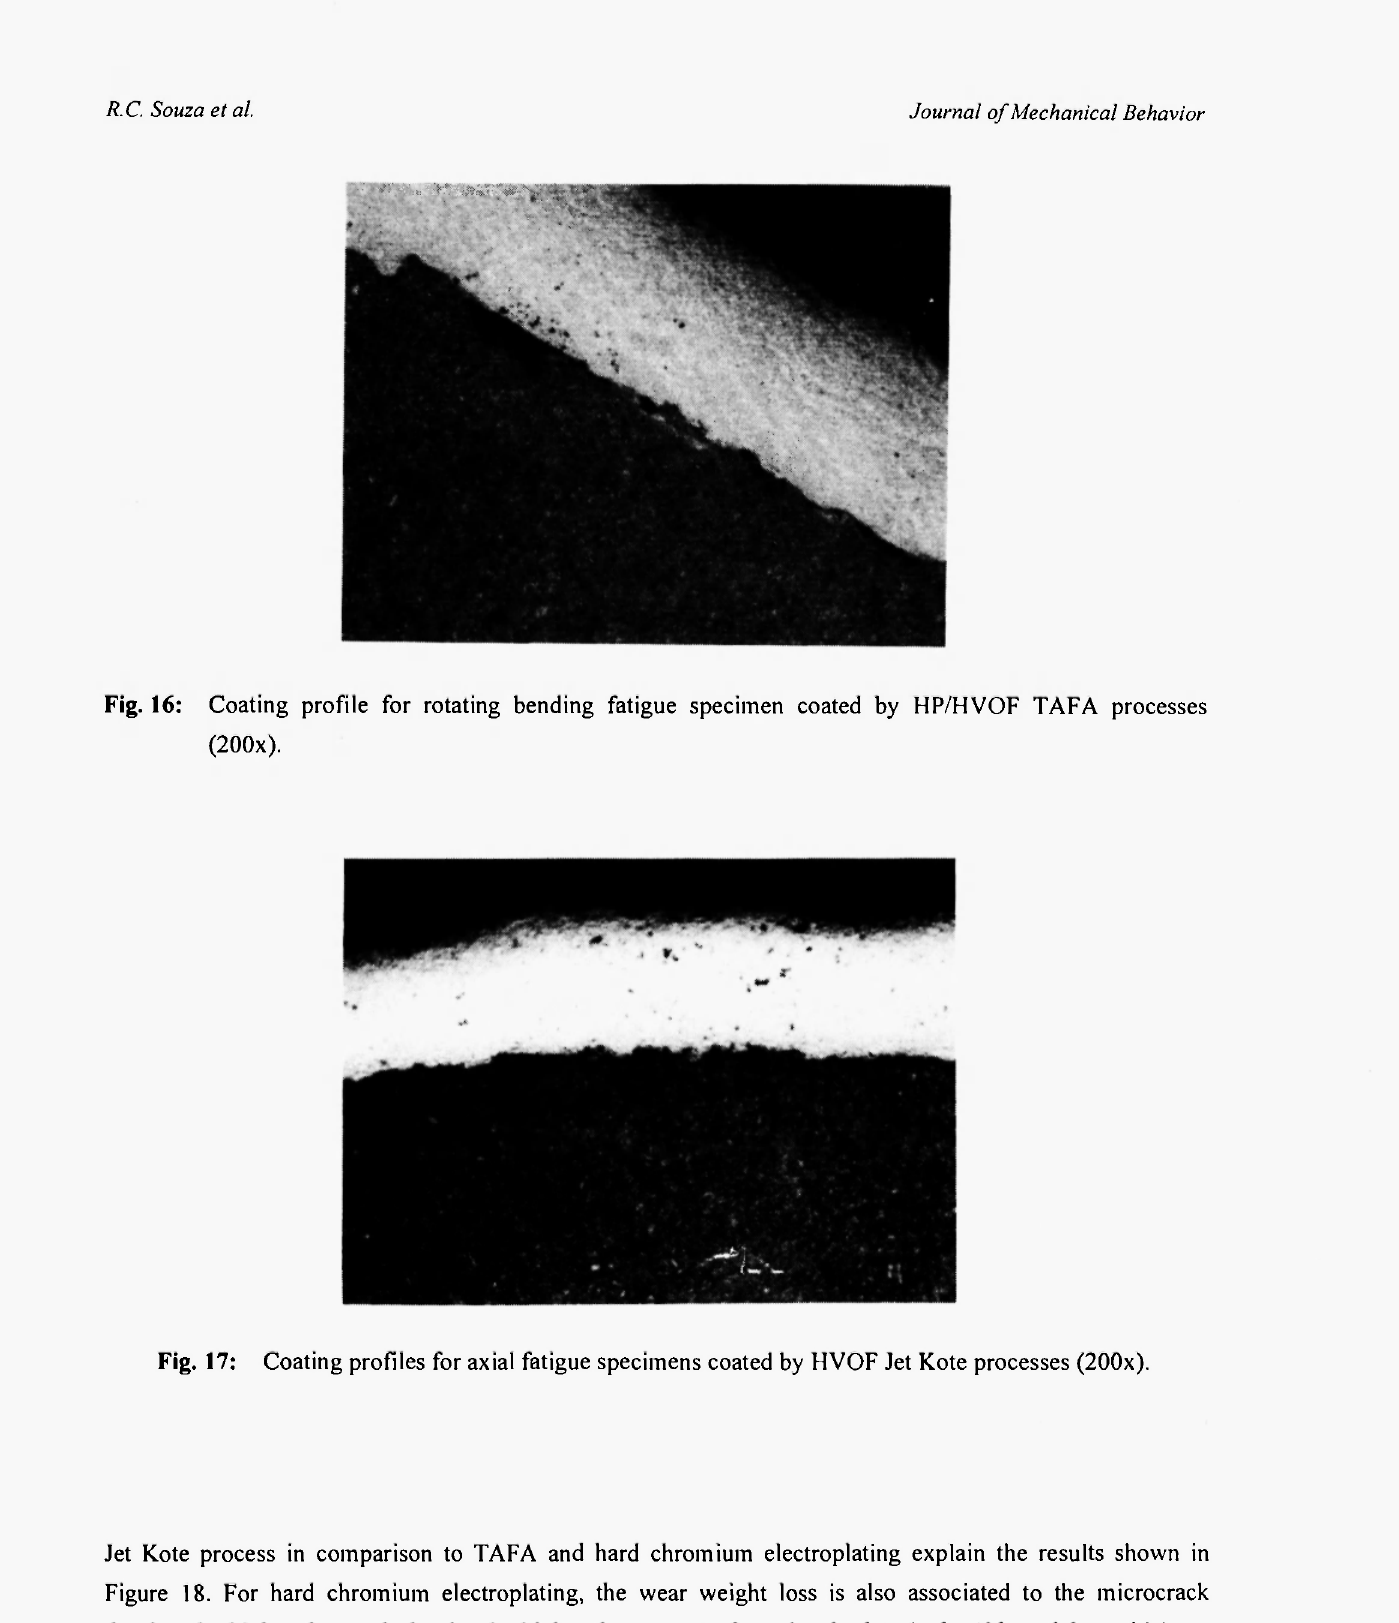
Jet Kote process in comparison to TAFA and hard chromium electroplating explain the results shown in Figure 18. For hard chromium electroplating, the wear weight loss is also associated to the microcrack density; the higher the crack density the higher the amount of previously detached solid particles, which are suppressed in the microcracks and decrease the wear